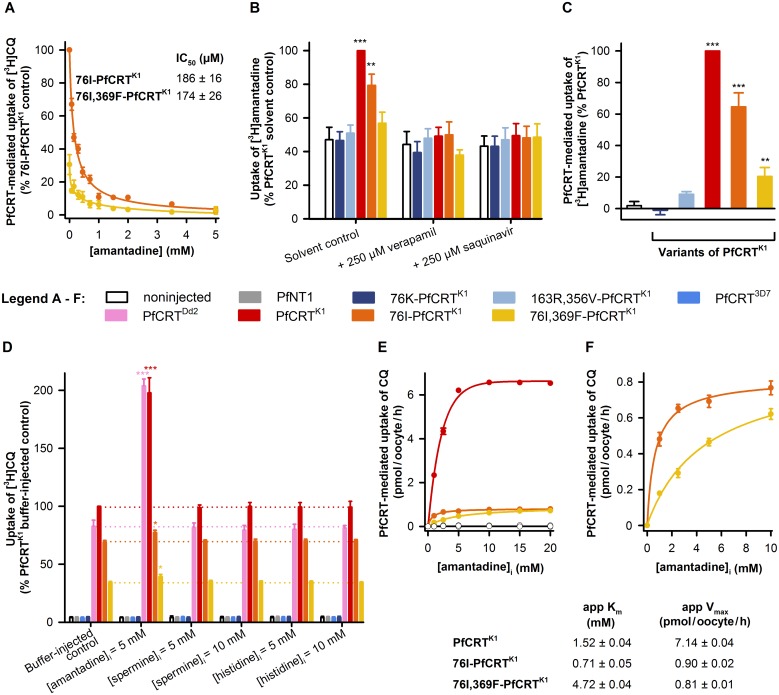
Isoforms of PfCRTK1 from amantadine-hypersensitive parasites transport amantadine.(A) Amantadine inhibits the transport of [3H]CQ via 76I-PfCRTK1 and 76I,369F-PfCRTK1 in a concentration-dependent manner (IC50s of 186 ± 16 and 174 ± 26 μM, respectively). (B) The uptake of [3H]amantadine (0.146 μM) in the absence and presence of verapamil or saquinavir. The measurements were undertaken at pH 5.0 and in the presence of 50 μM unlabeled amantadine. (C) The PfCRT-mediated transport of [3H]amantadine. Using the data shown for the solvent control in panel B, the component of [3H]amantadine transport attributable to PfCRT was calculated by subtracting the background level of accumulation (i.e., the average of the uptake measured in noninjected oocytes and oocytes expressing 76K-PfCRTK1) from that measured for each of the oocyte types. The rates of amantadine uptake (nmol per oocyte/h) in noninjected oocytes and PfCRTK1-expressing oocytes were 5.4 ± 0.9 and 12 ± 2.8, respectively. The asterisks denote a significant difference from the noninjected control: *P < 0.05; **P < 0.01; ***P < 0.001 (one-way ANOVA). (D) Trans-stimulation of PfCRT-mediated [3H]CQ transport by unlabeled amantadine. The oocytes were microinjected with a buffer control or with buffer containing amantadine, spermine, or histidine. The estimated intracellular concentrations ([compound]i) are indicated. The asterisks denote a significant difference from the relevant buffer-injected control. (E) Concentration-dependence of the trans-stimulation of [3H]CQ uptake by amantadine. The oocytes were microinjected with buffer containing amantadine to achieve an estimated [amantadine]i of 1 to 20 mM. The app Km and app Vmax values are the apparent kinetic parameters for the trans-stimulatory effect of amantadine. The data show CQ uptake above that measured in the relevant buffer-injected control; the total rates of CQ uptake are presented in S6 Fig. The noninjected data overlays the data obtained with oocytes expressing PfNT1, PfCRT3D7, or 76K-PfCRTK1. (F) A magnified plot of the 76I-PfCRTK1 and 76I,369F-PfCRTK1 data from panel E. In all panels, the data are the mean ± SEM of five independent experiments (performed using oocytes from different frogs), within which measurements were made from 10 oocytes per treatment. Where not shown, error bars fall within the symbols.